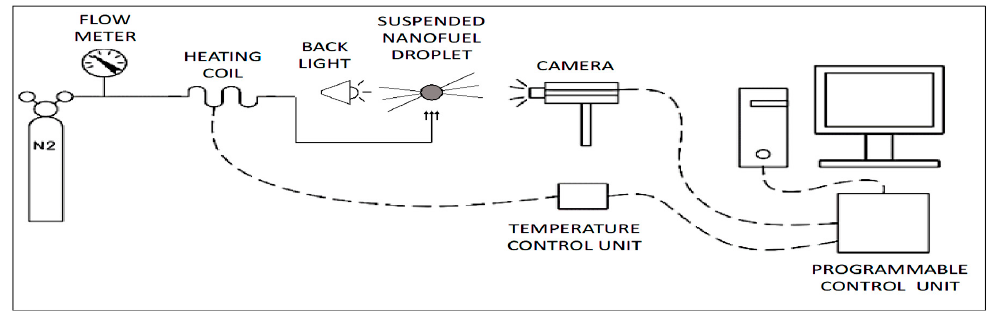
Figure 2. Schematic of droplet evaporation arrangement.